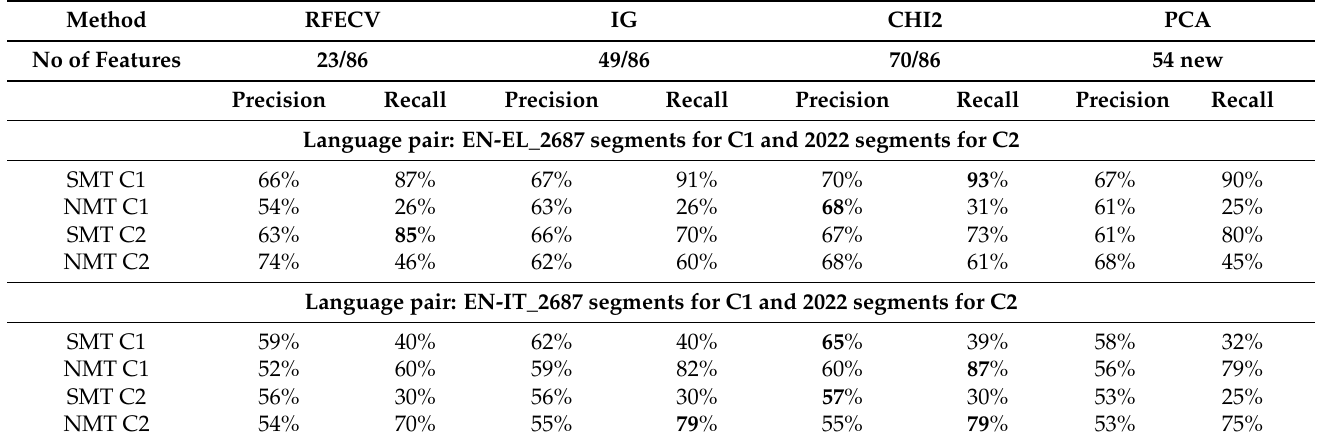
Table 4. Feature selection accuracy performance for the two corpus